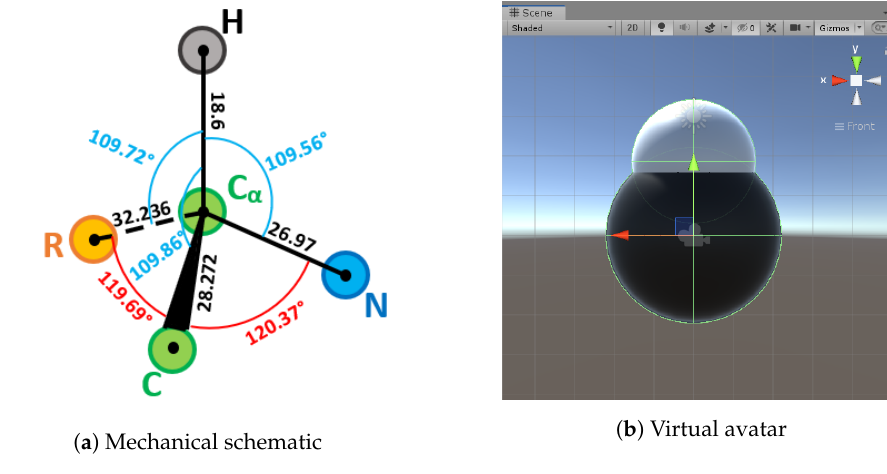
Figure 16. Alpha carbon